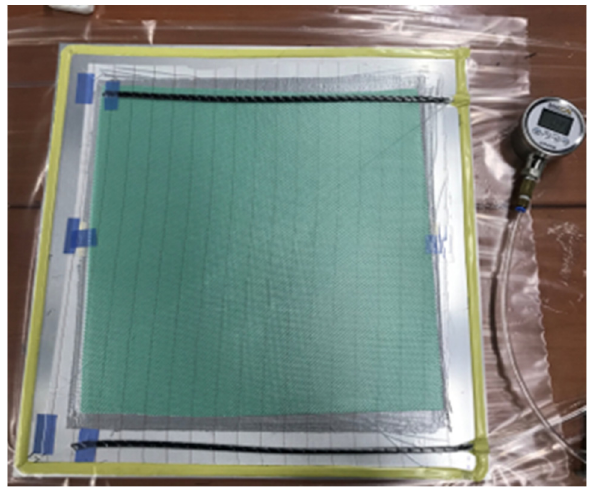
Figure 5. Specimen manufacturing